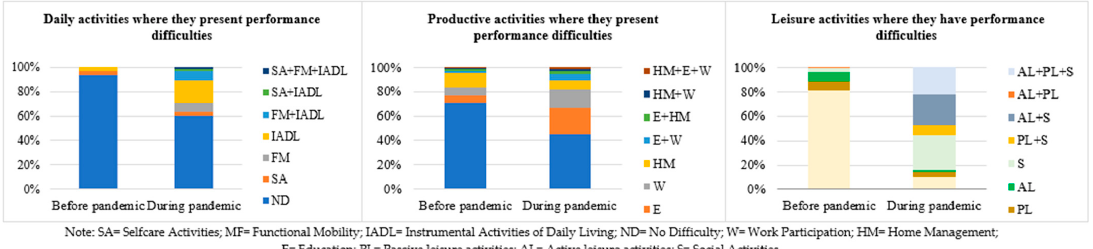
Figure 3. Activities where they present performance difficulties.